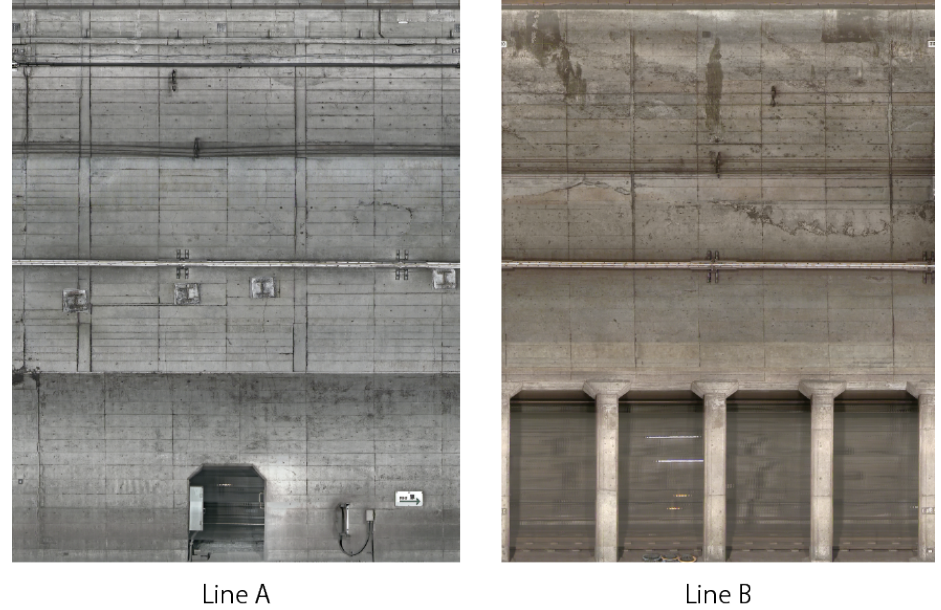
Figure 2. Examples of image of two lines (lines A and B) in the